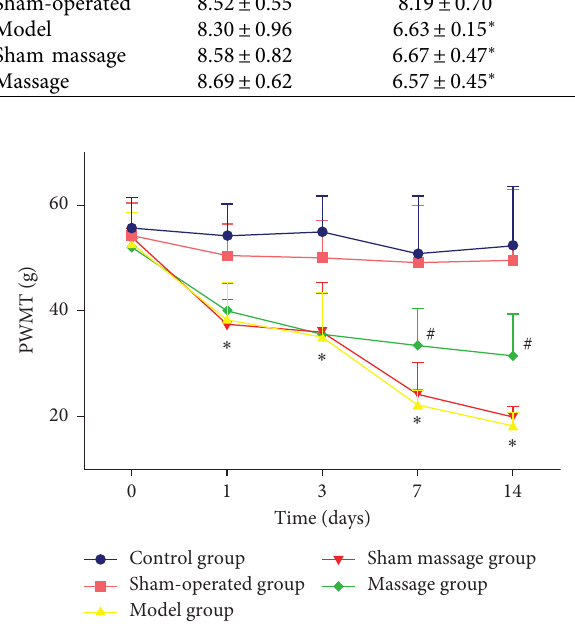
Figure 1: PWMTs of the groups 1 day, 3 days, 7 days, and 14 days after surgery. ∗ P < 0 . 05 compared with the control group; # P < 0 . 05 compared with the model group.